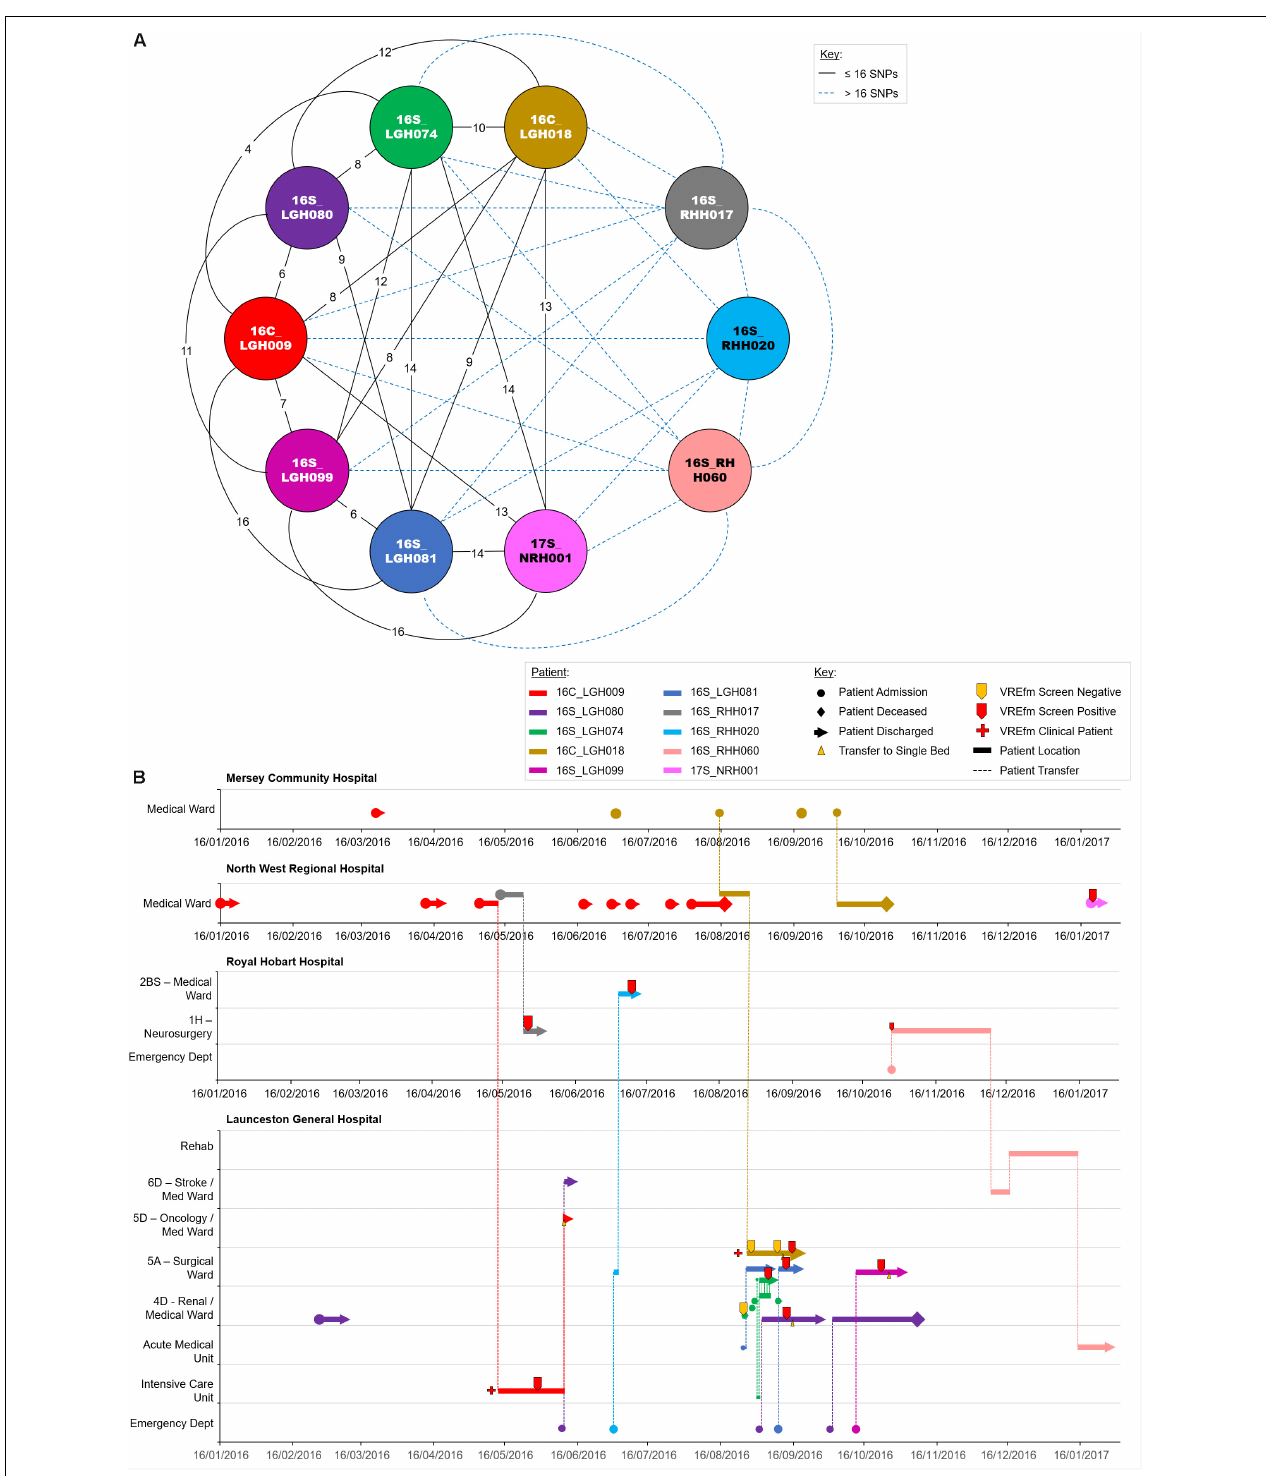
FIGURE 7 | Phylogenetic analysis of vancomycin-resistant Enterococcus faecium (VREfm) isolates from ST1421 Cluster 3A. The previously described recombination-filtered SNP threshold of ≤ 16 SNPs for VREfm has been used as a guide for identifying clonally related or non-unique isolates. (A) Overview of recombination-filtered SNPs between isolates. The numbers of different SNPs between the isolates are shown on the solid black connecting lines. SNP differences above the threshold of 16 SNPs are shown as blue dotted lines. (B) Spatio-temporal location of patients in Cluster 3A who tested positive for VREfm. The movement of patients following admission to hospital through to date of discharge are indicated with respect to time ( x -axis) and hospital ward location ( y -axis). Each line color represents an individual patient. As illustrated, a number of patients had multiple admissions to more than one hospital over the time course.